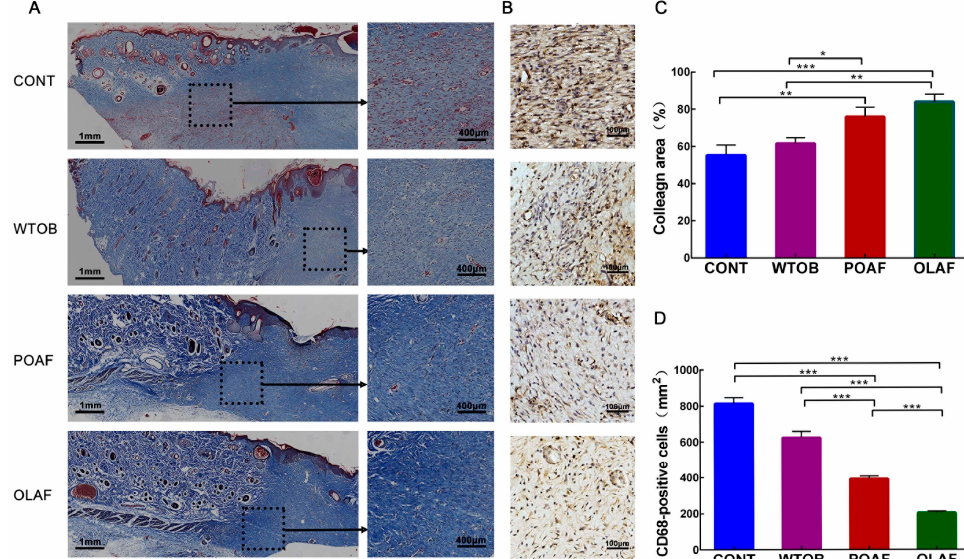
Figure 2. Effect of oleosomes fused with human fibroblast growth factor 1 (OLAF) on collagen deposition and macrophages at the wound sites. ( A ) Images of stained collagen fibers in wound sites harvested at 15 days post-wounding (blue color), where the collagen areas adjacent to the wound edge are indicated by the black dotted line. ( B ) Immunohistochemical staining showing CD68 expression in the wounds after 3 days treatment (brown color). Scare bar: 100 µ m. ( C ) Quantification of the collagen content per microscopic field in wound tissue collected from different groups at 15 days post-exposure. ( D ) Density analysis of CD68-positive cells (per mm 2 ). * p < 0.05, ** p < 0.01, *** p < 0.001. The mean ± SD was employed to display all the obtained data (n =